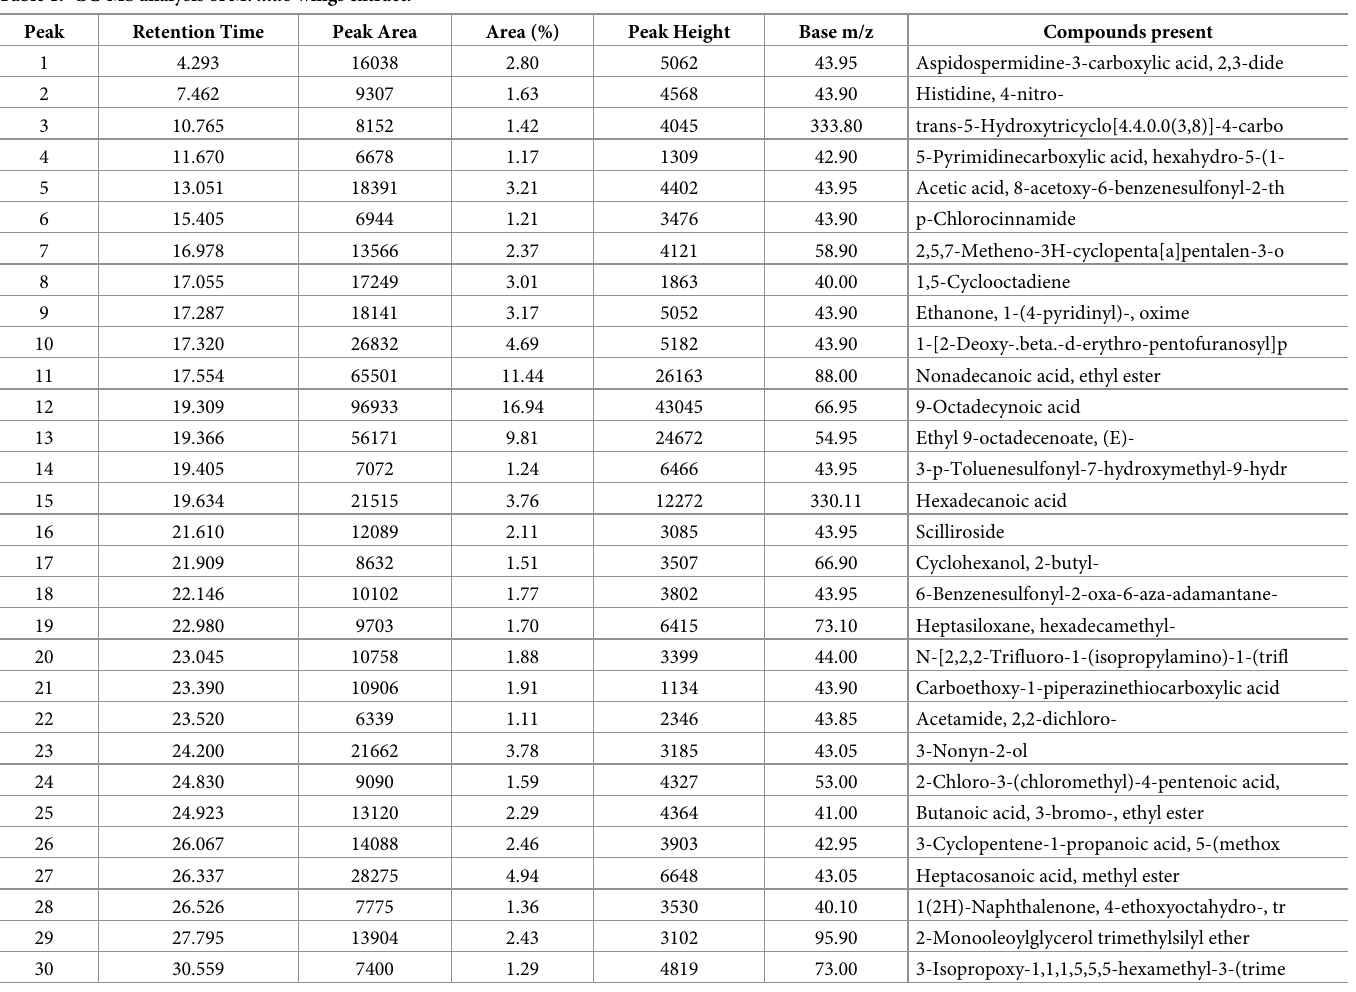
Table 1. GC-MS analysis of M . mao wings extract.